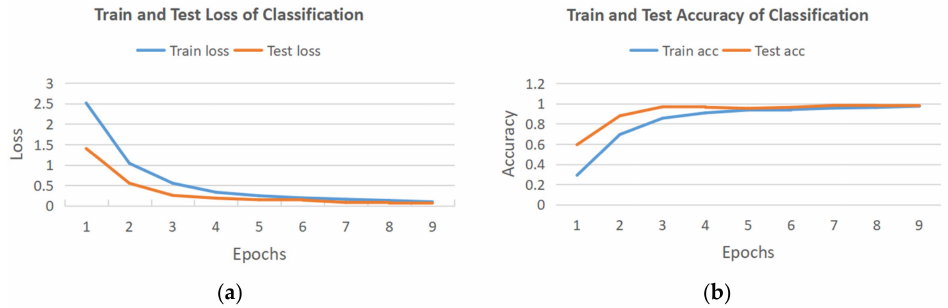
Figure 9. The training and testing process of the model for raw data: ( a ) train and test loss; ( b ) train and test accuracy.